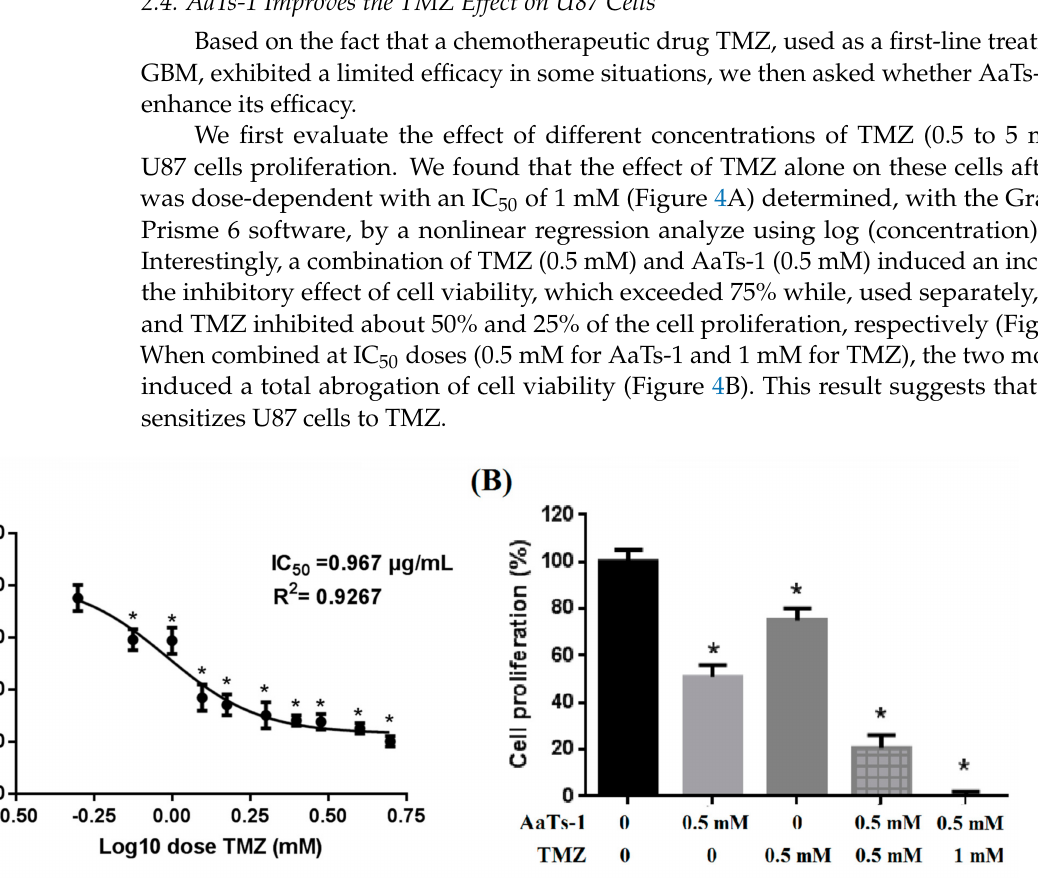
Figure 4. Effect of TMZ on U87 cell proliferation. ( A ) Dose-response effect of TMZ on U87 cell proliferation. Cells were incubated with different concentrations of TMZ (0.5 to 5 mM) for 72 h. ( B ) Co-treatment of U87 cells with TMZ and AaTs-1. U87 cells were incubated with a combination of AaTs-1 (0.5 mM) and TMZ (0.5 mM or 1 mM). Mean, SD. * p < 0.05, significantly different from